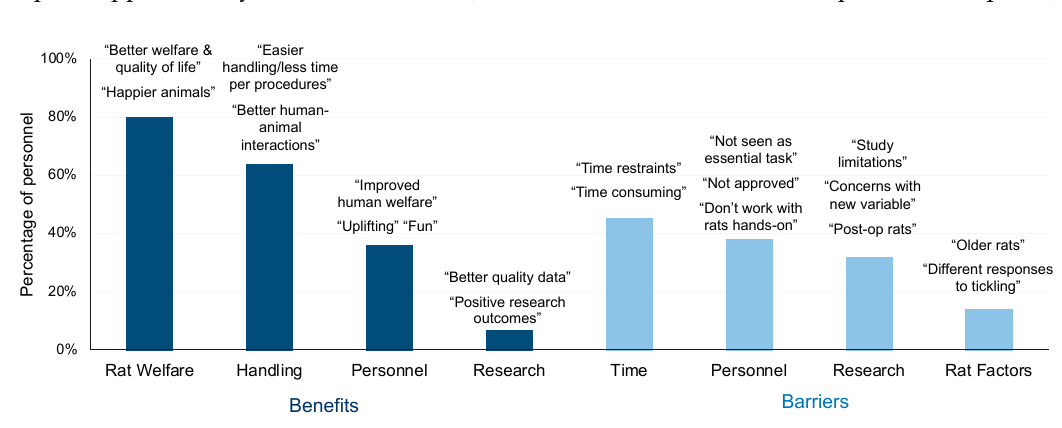
Figure 6. Trained personnel—benefits and barriers to rat tickling. The most common themes related to benefits (advantages) and barriers (factors making it difficult) to tickle rats reported by 86 laboratory animal personnel in a 2-month follow-up survey. Graphic includes representative quotes. Sub themes and additional representative quotes are presented in Supplemental Table S2.